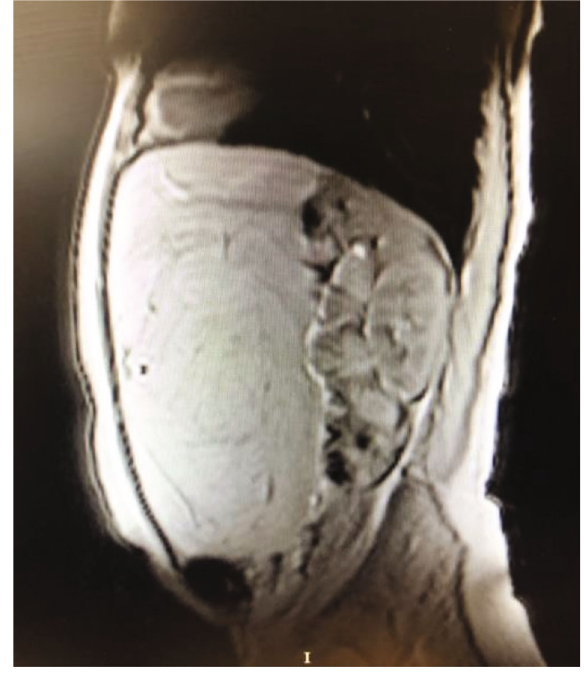
Figure 3: Sagittal view of magnetic resonance imaging shows that the lesion caused the intestines to move towards the posterior.